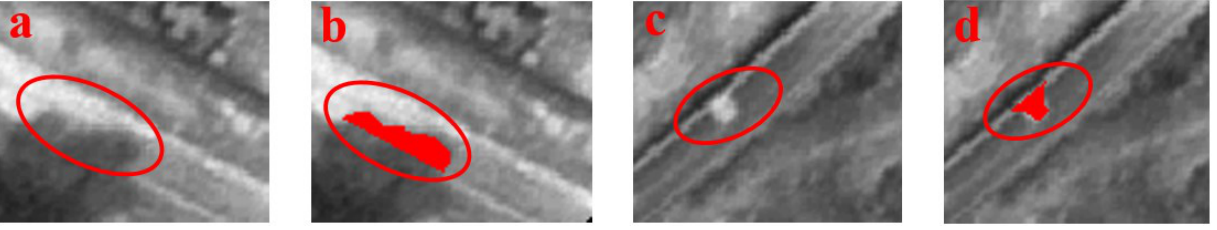
Figure 11. Tree and vehicle that are mistaken as damaged roads. ( a ) Tree shadow; ( b ) Tree shadow is mistaken as damaged road; ( c ) Vehicle; ( d ) Vehicle is mistaken as damaged